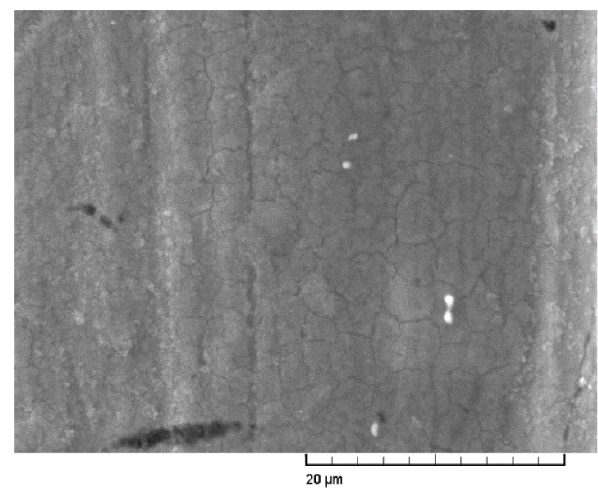
Figure 11. SEM image of the worn surface of the GCr15 at high magnification in a seawater